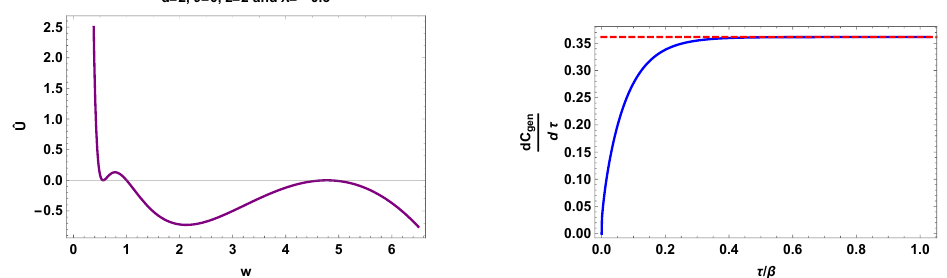
Figure 18 . The case d = 2 , θ = 0 , z = 2 and λ = − 0 . 3 : Left ) The effective potential as a function of w . For this value of λ , there are two maxima. There is a maximum w is the solution to equation A ( λ, w ) = 0 and there is another one w the solution to equation B ( λ, w ) = 0 . Right ) The growth rate d C gen growth rate is given by the value of ˆ U ( w ) at the maximum w eq. (3.23). This value is shown by the horizontal dashed red line. Notice that ˆ U ( wf hence it gives a zero contribution to eq. (3.23).